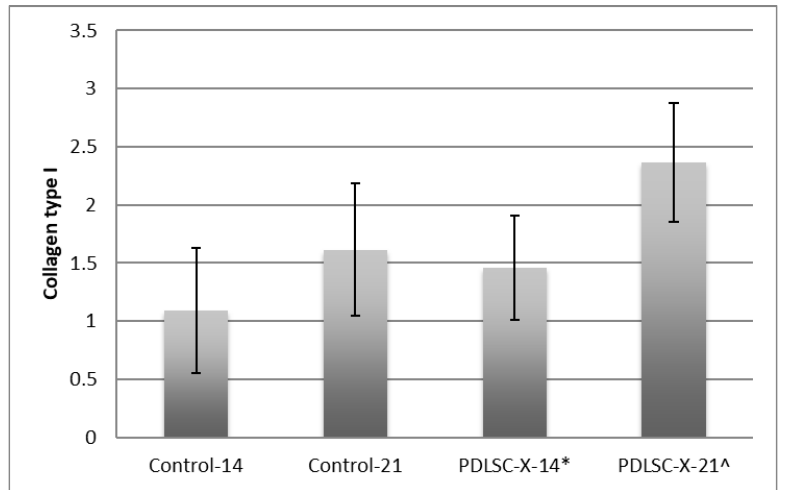
Figure 1. Mean collagen type I ( μg) distribution according to the duration of culture and graft material among the study groups. * significant compared to Control-14, significant compared to Control-21.